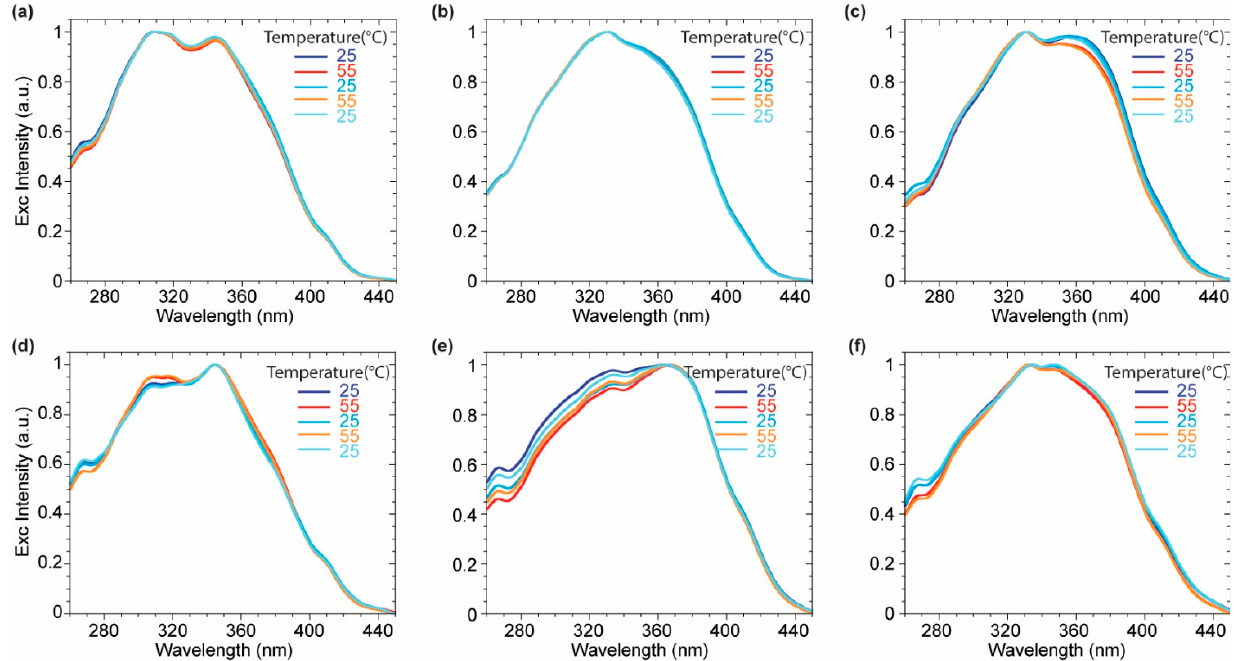
Figure 7. Normalized excitation spectra of compounds 2 ( a , d ), 3 ( b , e ), 4 ( c , f ) in DOPC ( a – c ), and DPPC ( d – f ) over the heating cycles.